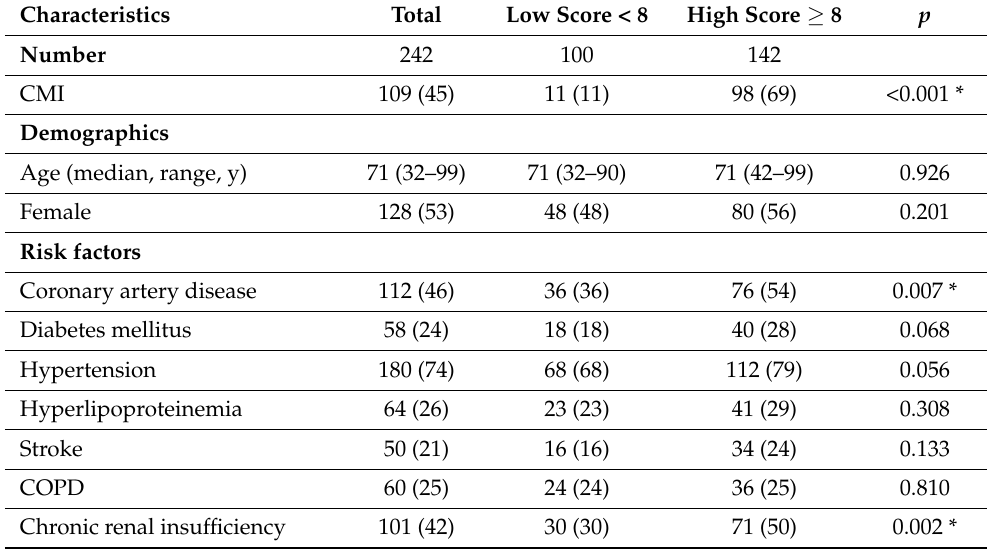
Table 1. Demographics and risk factors of the patients, number of affected vessels, and location of mesenteric artery